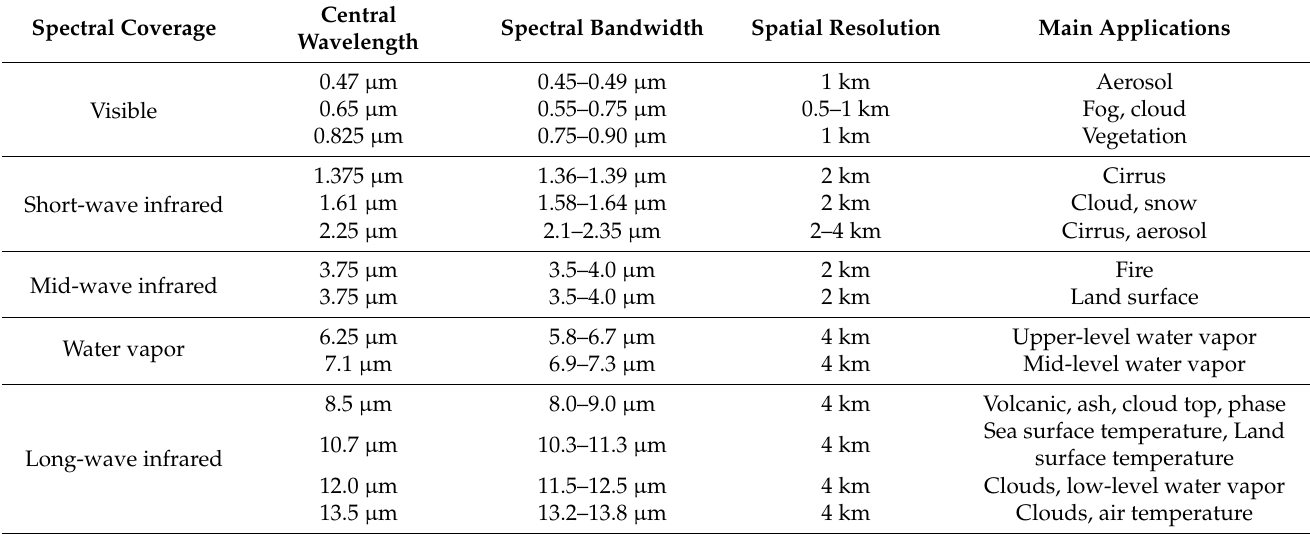
Table 1. The AGRI band observation information of the FY-4A satellite 1 .